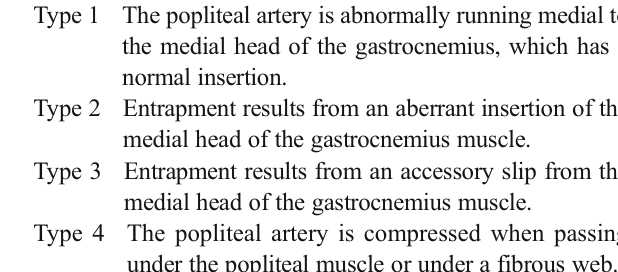
Fig. 6 Popliteal artery entrapment syndrome (PAES)in a 31-year-old woman admitted to the hospital because of a 6-week history of right calf pain and numbness. Patient also reported half-block claudication. ( a ) Lower extremity digital subtraction angiography reveals obliteration of the popliteal artery ( arrow ). Given the lack of risk factors for an arterial thrombus, an anatomic etiology was suspected. ( b , c ) Axial selective partial inversion recovery (SPIR) MR images of the right knee showing an accessory slip of the lateral head of the gastrocnemius muscle ( arrow ) crossing anterolateral to the popliteal vessels, with resulting compression of the popliteal artery ( arrowhead ). The accessory slip ( arrow ) joins the lateral head of the gastrocnemius distally ( star ). This finding supports a diagnosis of PAES